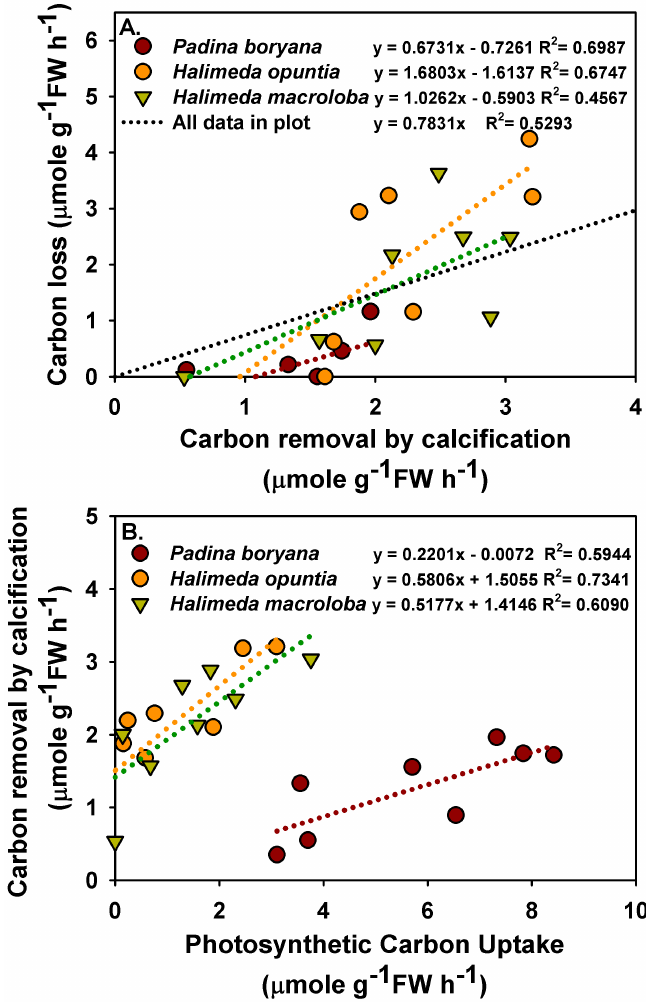
Figure 4. Relationship between carbon removal by calcification and carbon lost to air ( A ) and between photosynthetic carbon uptake and removal by calcification ( B ) in treatments incubated with Padina boryana , Halimeda opuntia and Halimeda macroloba . Fittings using linear regressions are shown as dotted lines, and the equations are displayed. Data are obtained from calculations shown in Figure